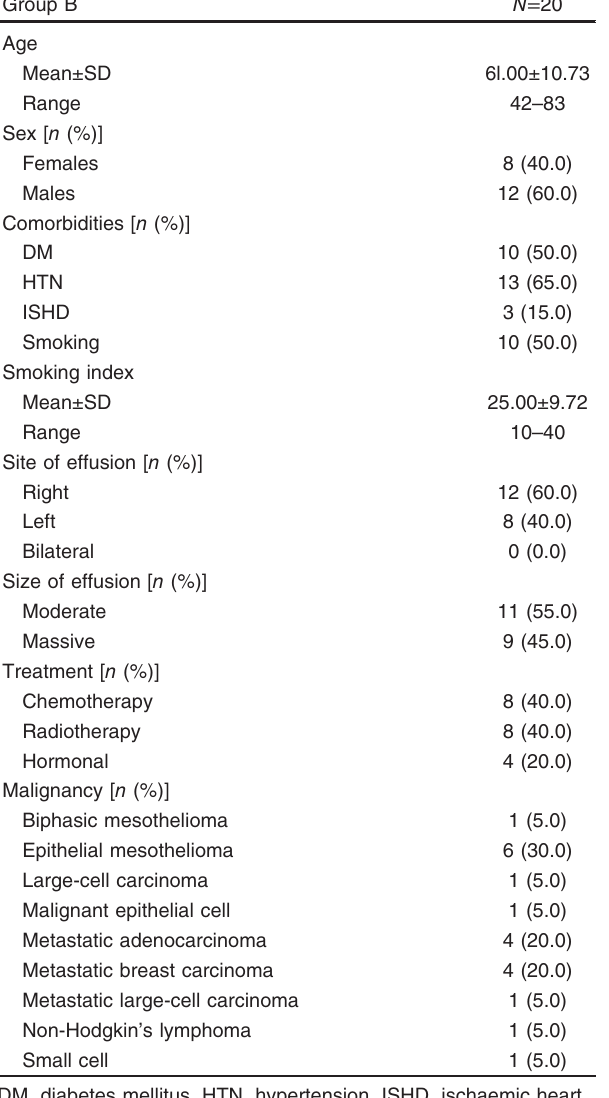
Table 2 Demographic characteristics of group B (patients submitted to rapid pleurodesis technique) Group B N = 20